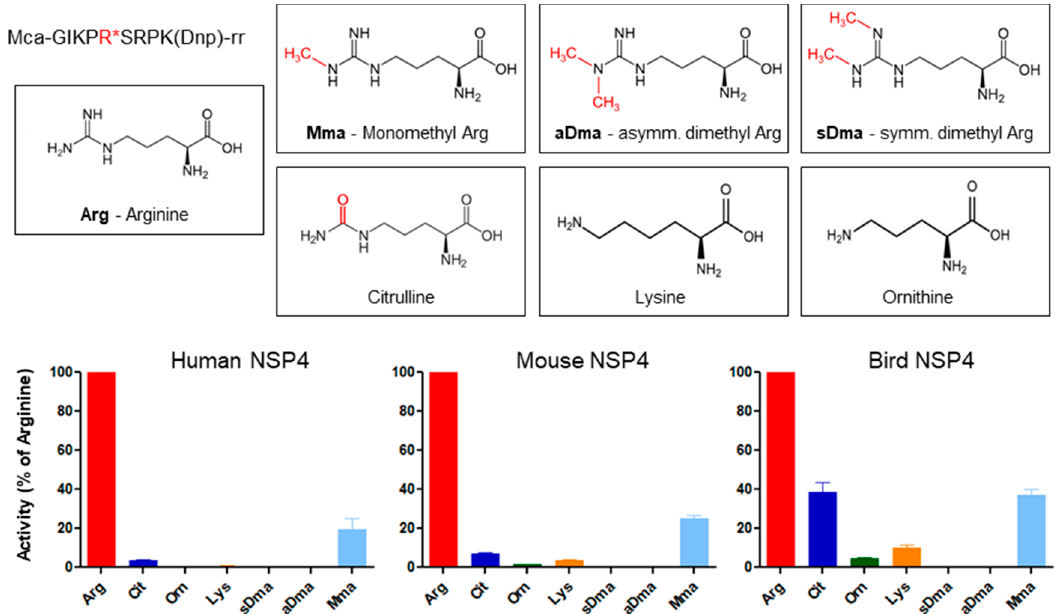
Figure 4. Hydrolysis after unmodified arginine residues is preferred by neutrophil serine protease 4 (NSP4) in birds, mice, and men. The activity of human, mouse, and bird NSP4 was determined by activity assays of 40 nM NSP4 from the different species using specific FRET substrates ( λ ex = 325 nm λ ex = 392 nm) (2 µ M) as previously reported in [55]. Substrates contained modified arginine residues at position P1. In addition, citrulline (Cit), lysine (Lys), and ornithine (Orn) specific substrates were included in the analysis (Perera N.C., unpublished results).